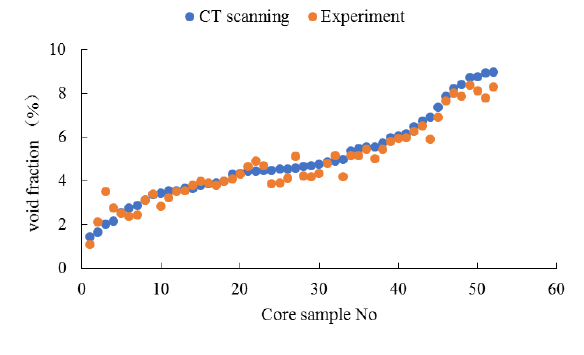
Fig. 5 Comparison of void fraction results of core